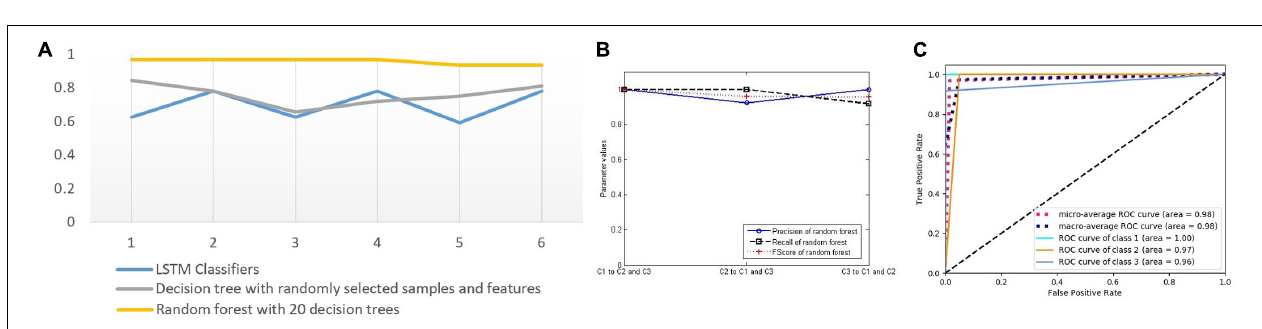
FIGURE 8 | The performance of two decision trees constructed by C4.5 algorithm. (A) Three classification performance indicators of two decision trees. (B) The receiver operating characteristic (ROC) curves and the area under the curve (AUC) values of decision tree 1. (C) The ROC curves and the AUC values of decision tree 2.